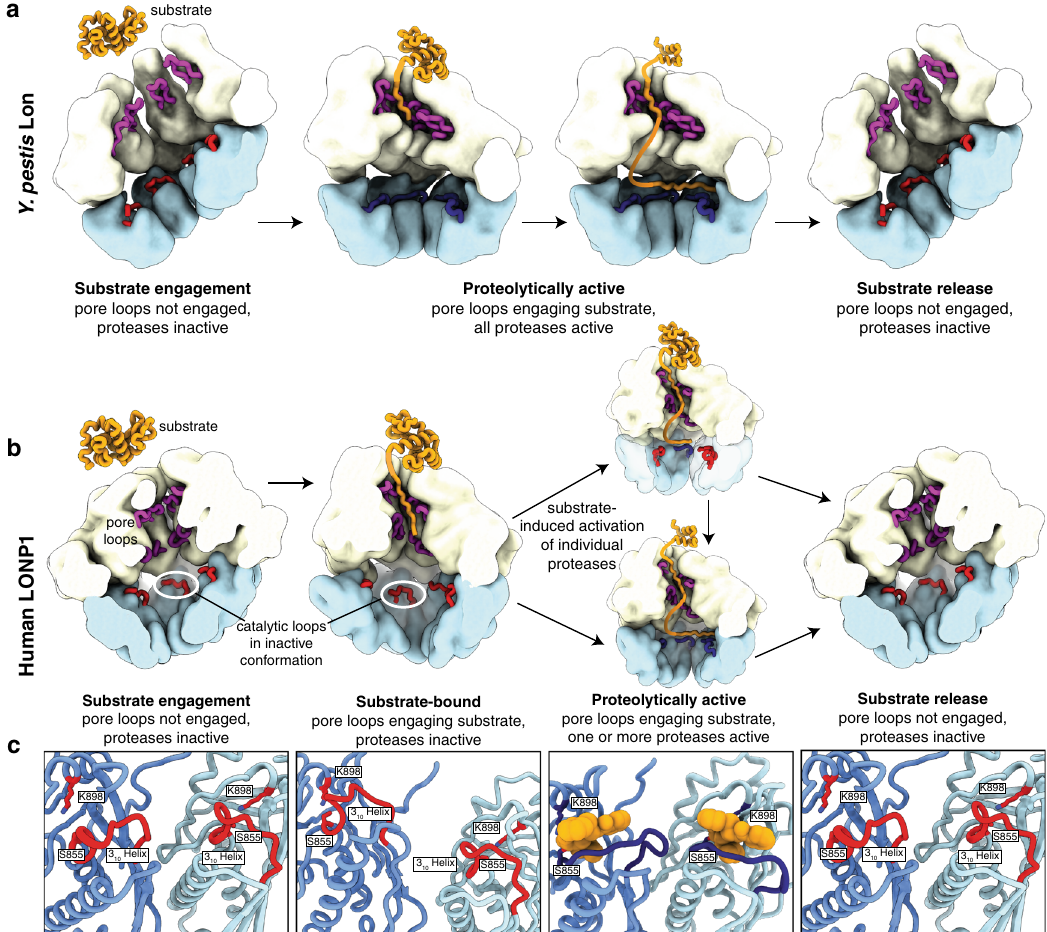
Fig. 5 Models for protease activation in Y. pestis and human LONP1. a In Y. pestis Lon, substrate is engaged by the open state conformer (left) with inactivated protease domains (red), causing a transition to a translocation-competent organization of the ATPases (middle, left). Substrate engagement by the pore loops (purple) in the central channel induces protease activation (dark blue). A conformational change to the activated, C6-symmetric protease conformation precedes substrate entering the protease active site (middle, right). Substrate is released upon Lon protease transitioning back to the open state conformer (right). b In Human LONP1, substrate is engaged by the open state conformer (left), causing a transition to a translocation-competent organization of the ATPases (middle, left). Despite substrate engagement by the pore loops (purple) in the central channel, the protease active sites remain in an inactive conformation (red). The protease domain is only activated in the presence of substrate (middle, right) in one (top) or more (bottom) protease domains, at which point the catalytic loop (red) extends away from the catalytic residues to enable substrate cleavage (dark blue). c Close-up views of the proteolytic active sites of substrate-free, substrate-bound, proteolytically active, and substrate-released LONP1 enzymes. In the inactive substrate-free and inactive substrate-bound states, a 3 10 helix sterically hinders substrates from entering the proteolytic active site for degradation in addition to preventing the formation of the catalytic dyad between S855 and K898. However, in the presence of substrate (represented by bortezomib in orange in the right panel) in the proteolytic active site, the catalytic serine-containing loop extends toward the neighboring subunit, the catalytic dyad is formed, and the protease domains activate for proteolytic